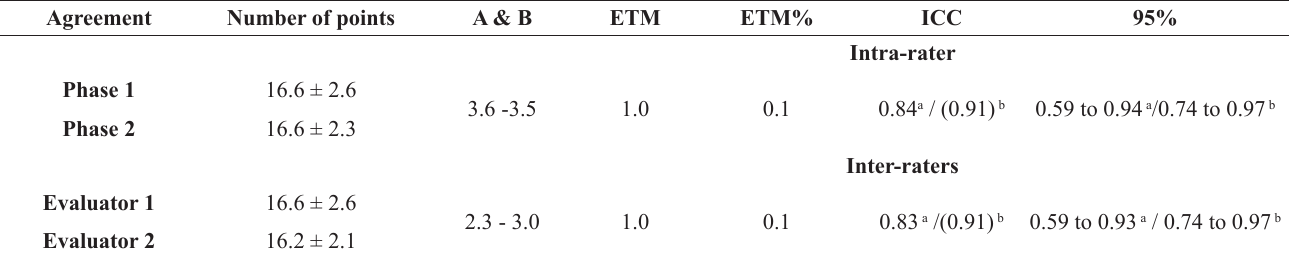
Table 6 - ICC inter-and intra-rater reliability of the scores from 0 to 21 points of DMA (*n = 16 and n = 17 for intra and inter-rater evaluation, respectively)